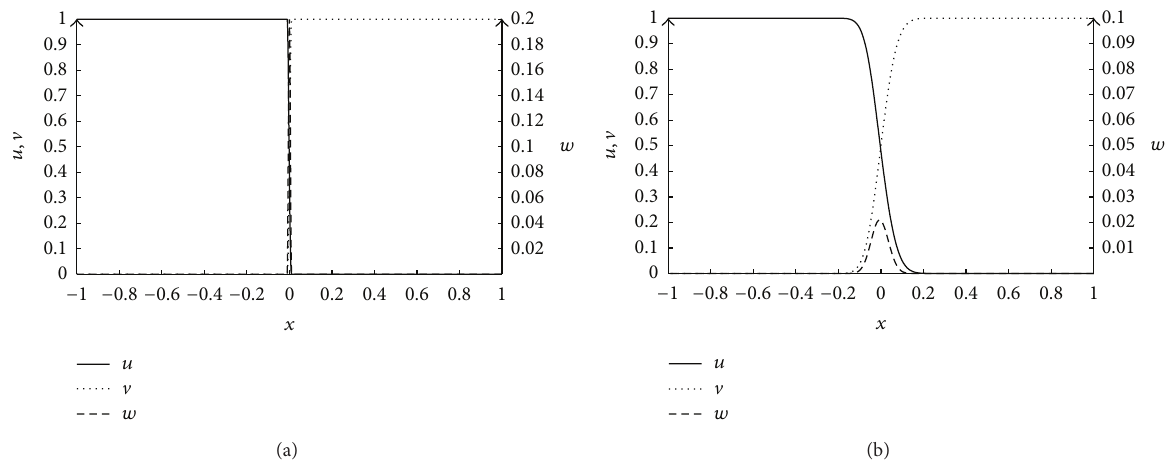
Figure 1: Initial values (a) and experimental values of 𝑢 , V , and 𝑤 for 𝑡 = 0.01 , ℎ = .002